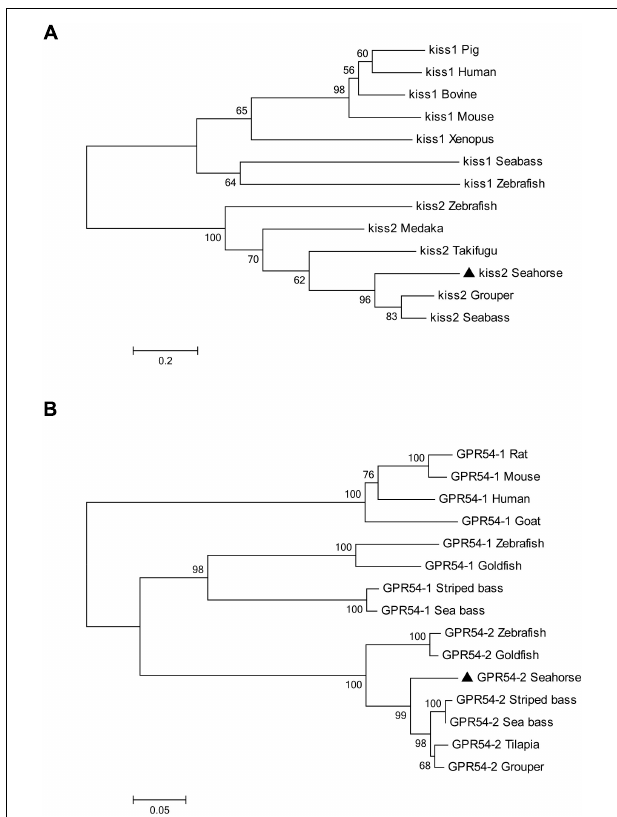
FIGURE 3 | Phylogenetic tree depicting the evolutionary relationships of lined seahorse Kiss2 and GPR54-2 with those of other vertebrates. The phylogenetic tree was contrasted by MEGA6.0 using the neighbor-joining method with 1000 bootstrap replicates. (A) The tree was constructed from the deduced amino acid sequences of vertebrate Kiss listed in Table 2 . Numbers at nodes indicate the bootstrap value (%), obtained for 1000 replicates. Kiss GenBank Accession Nos. are listed in Table 2 . (B) Phylogenetic tree of GPR54 in vertebrates. The number shown at each branch indicates the bootstrap value (%). GenBank accession numbers are as follows: human ( Homo sapiens ) GPR54-1 (NP_115940); rat ( Rattus norvegicus ) GPR54-1 (NP_076482); mouse ( Mus musculus ) GPR54-1 (NP_444474); goat ( Capra hircus ) GPR54-1 (ACY91951); zebrafish (